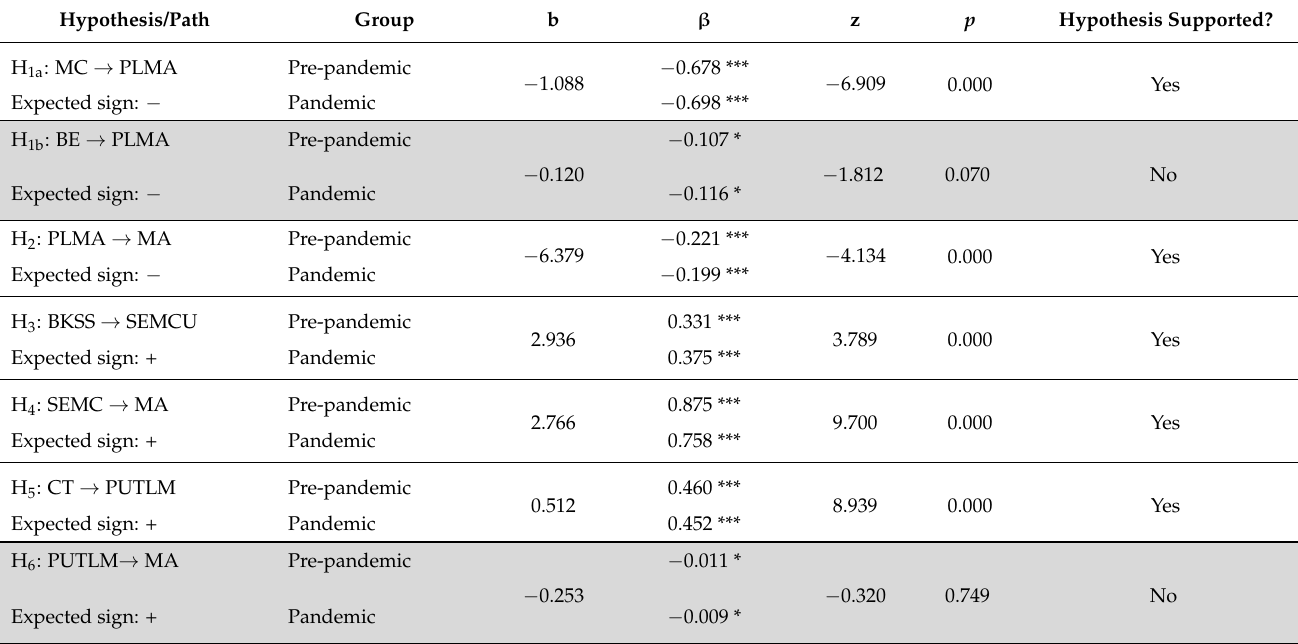
Table 8. Summary of research hypotheses